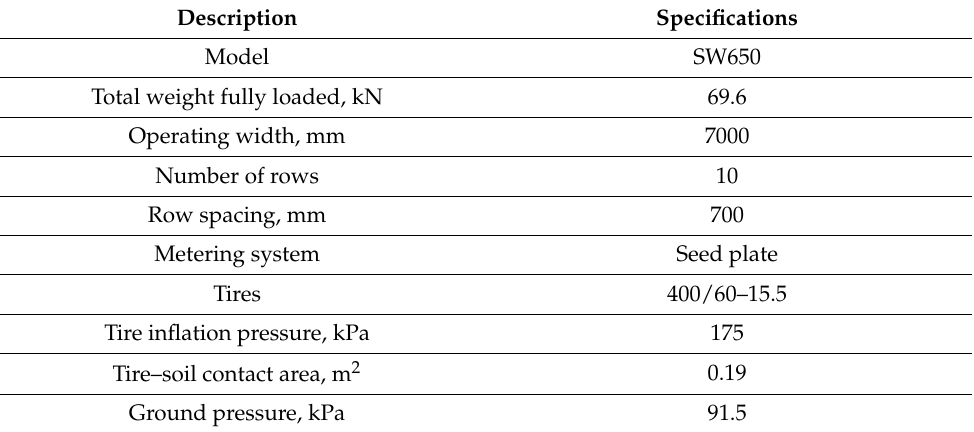
Table 3. Specification of the equipment used in the